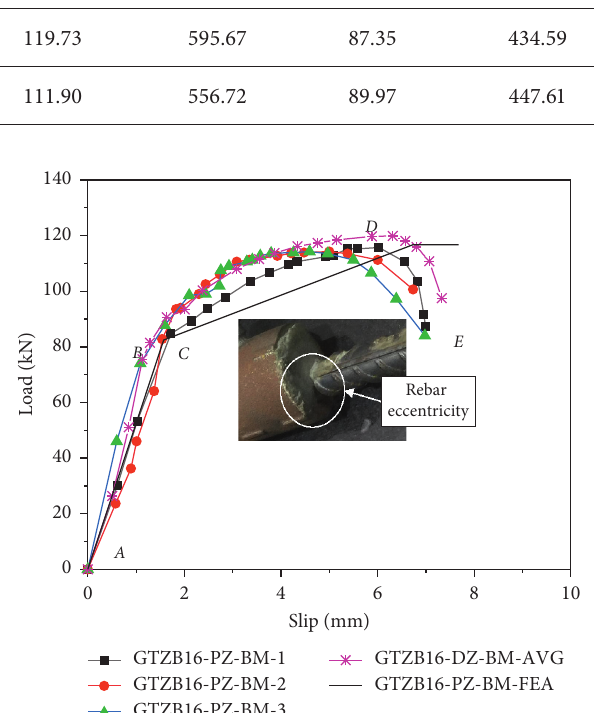
Figure 14: The load-slip curves of the rebar offset specimen (AVG: average value; FEA: finite element analysis).